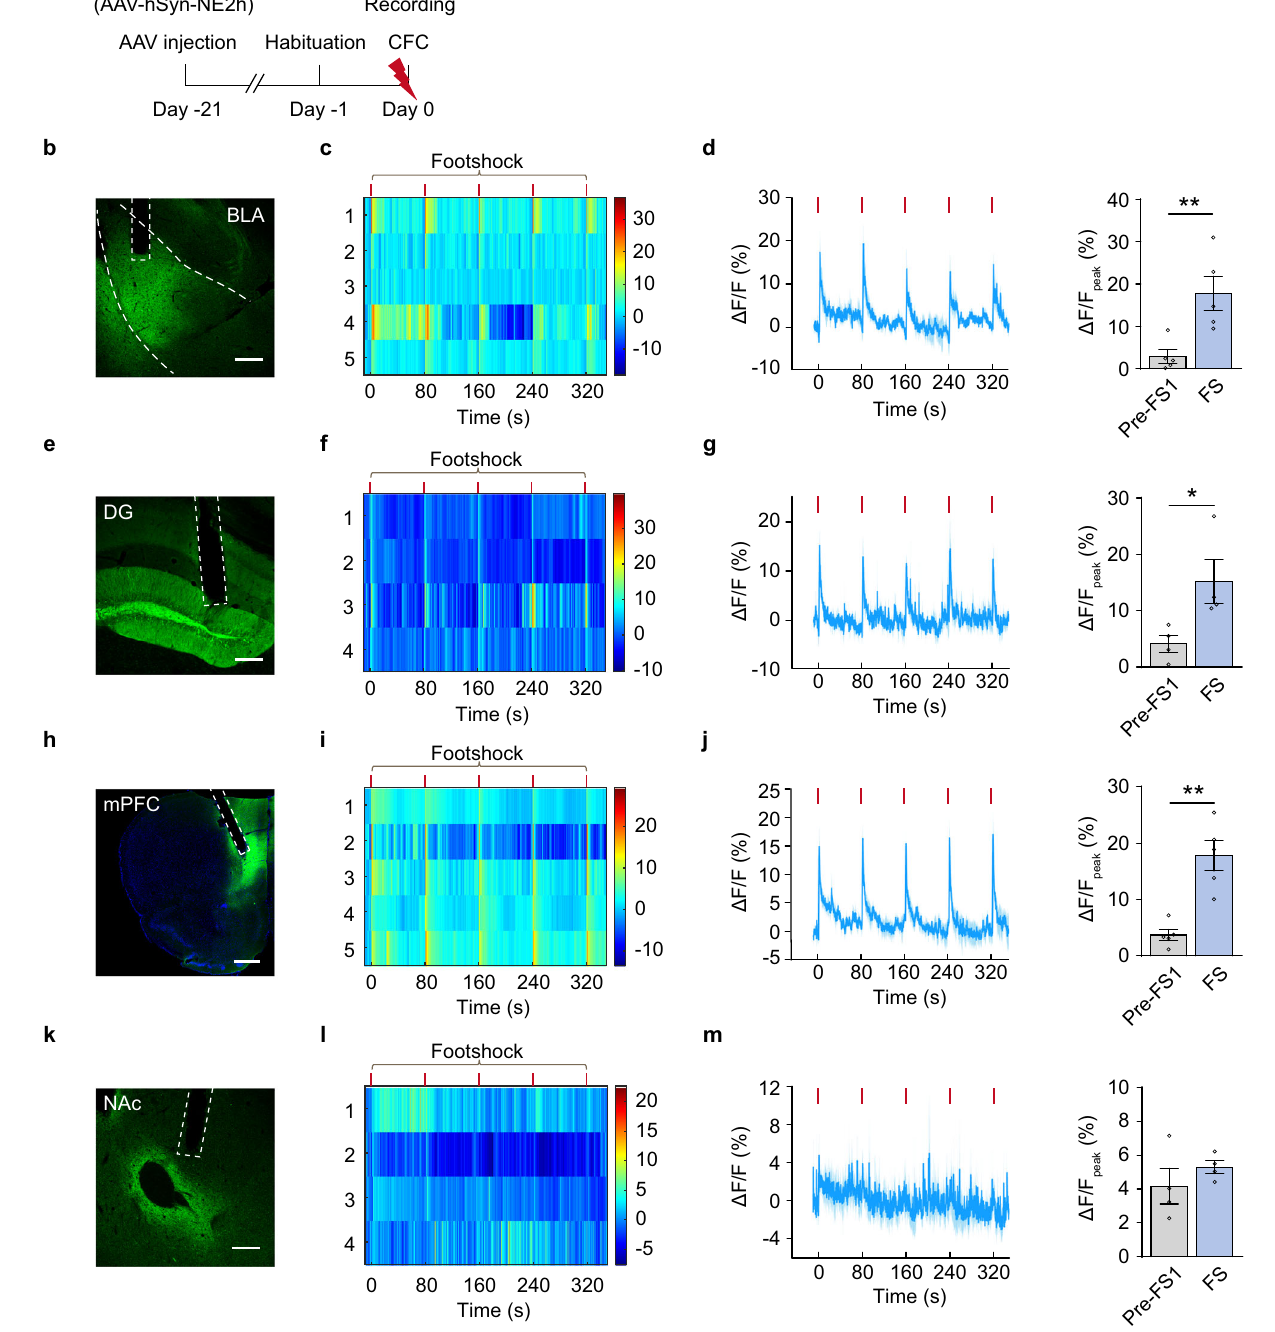
Fig. 1 | CFC increases NE release in the BLA, DG, and mPFC. a Experimental scheme. AAV-hSyn-NE2h was injected in the BLA, DG, mPFC, or NAc, and NE2h fl uorescence was recorded during contextual fear conditioning (CFC). b , e , h , k Representative images of NE sensor (NE2h) expression. c , f , i , l The heatmapsillustratetheaveragedresponseofNE2htoeachfootshock( Δ F/F %).Each row of heat map represents NE2h fl uorescence of a single mouse. Color scale